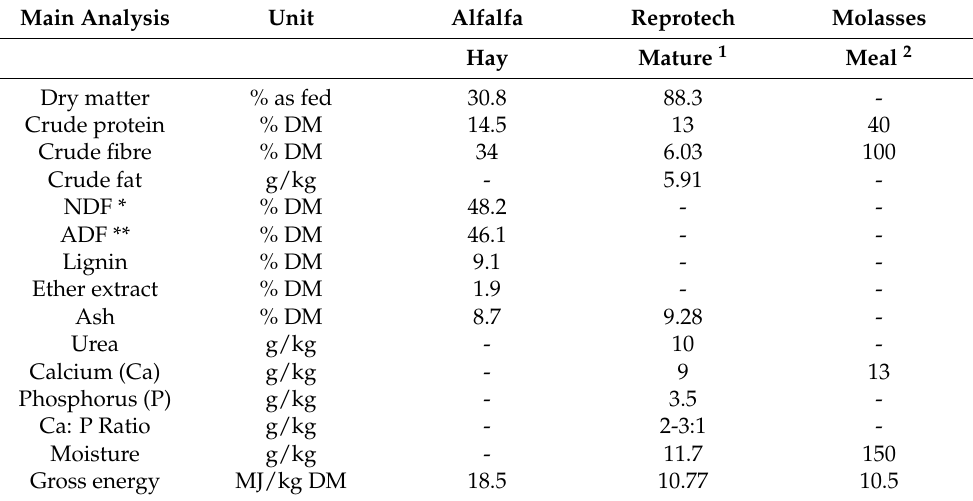
Table 1. Nutritional and chemical composition of Alfalfa hay, Reprotech Mature (AGFRI-Animal feeds ® ), and molasses meal